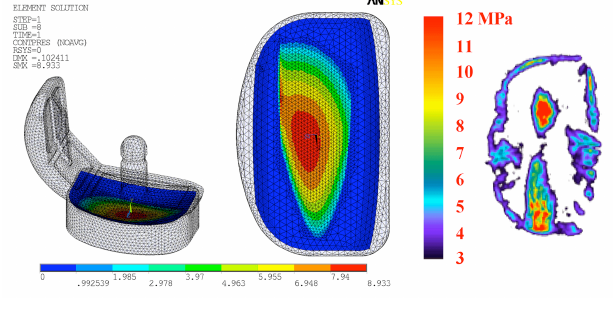
Fig.8. Free PE housing; Position 1